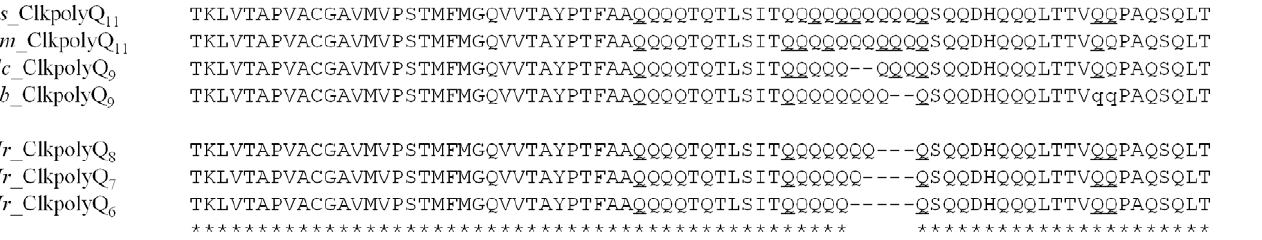
Figure 1. Amino acid alignment of avian CLOCK polyQ alleles. Alignment includes sequences from Barn Swallows ( Hirundo rustica ; Hr ) together with published Blue Tit ( Cyanistes caeruleus ; Cc ), Great Tit ( Parus Major ; Pm ), Bluethroat ( Luscinia svecica ; Ls ) and Tree Swallow ( Tachycineta bicolor ; Tb ). For each sequence the species name and number of Clock poly-Q repeats are shown. The predicted protein sequences of Barn Swallow Clock poly-Q repeats only differ in the number of CAG codon (coded by Q) repeats (The first and last glutamine (Q) amino acids in the poly-Q repeat were coded by CAA codons). Q residues coded by CAA are underlined and lower-case Qs are within-population polymorphic site encoded by either CAA or CAG. Asterisk indicates identical amino acids in the poly-Q flanking region between the all